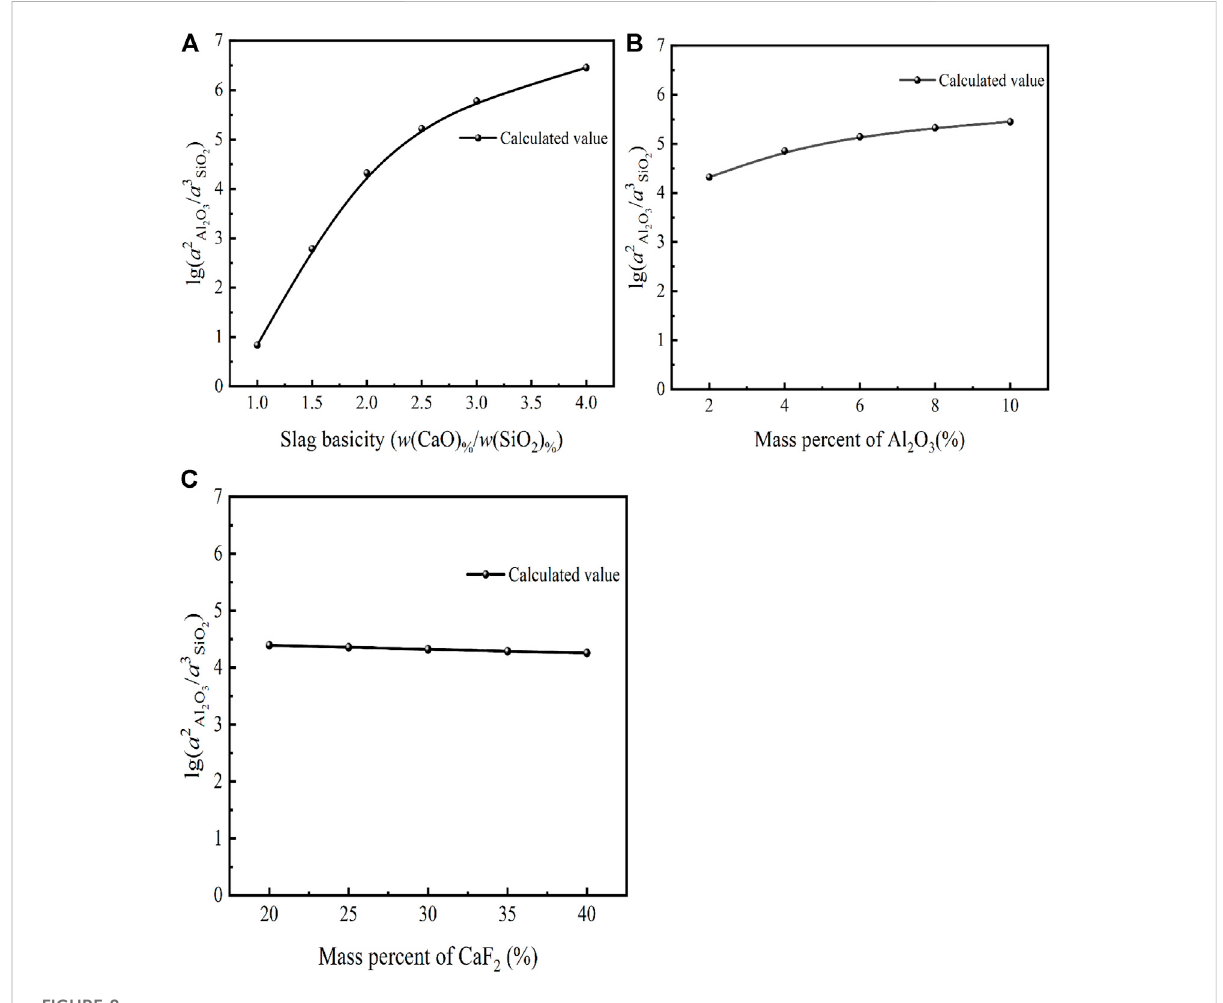
FIGURE 8 Model predictions of the relationship between (A) CaO, (B) Al 2 O 3 , (C) CaF 2 and